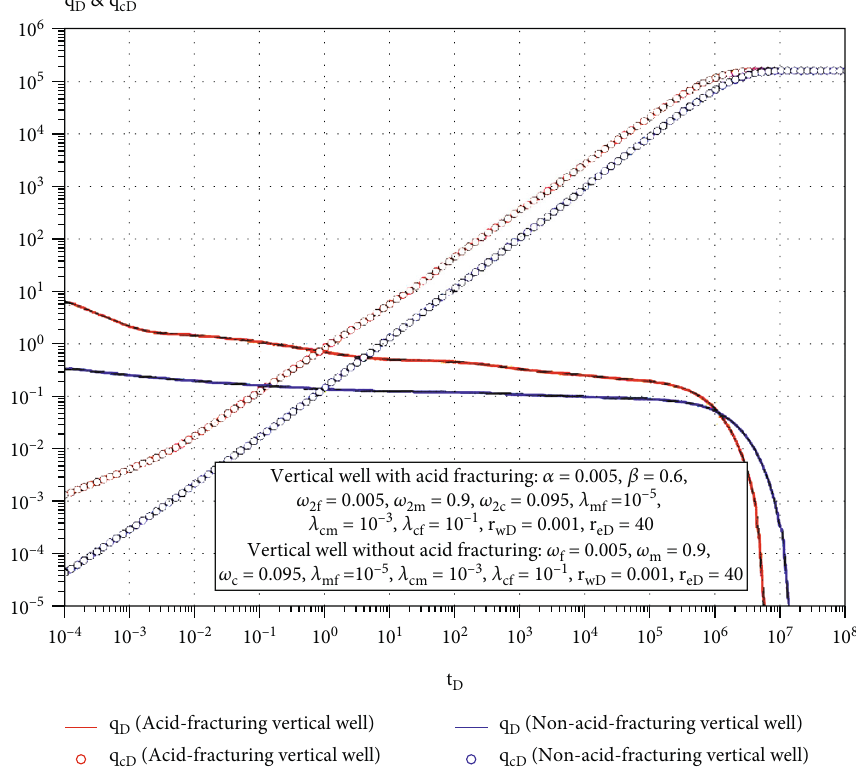
Figure 6: Comparison of instantaneous rate and cumulative productivity between acid-fracturing vertical well and non-acid-fracturing vertical